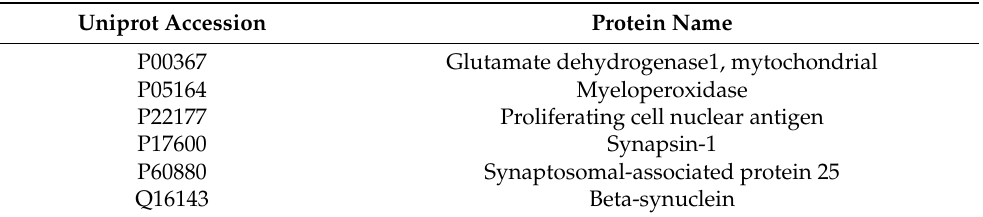
Table 4. List of the six proteins with statistically higher mean levels in CUSA A- with respect to CUSA A+ ( p -value <